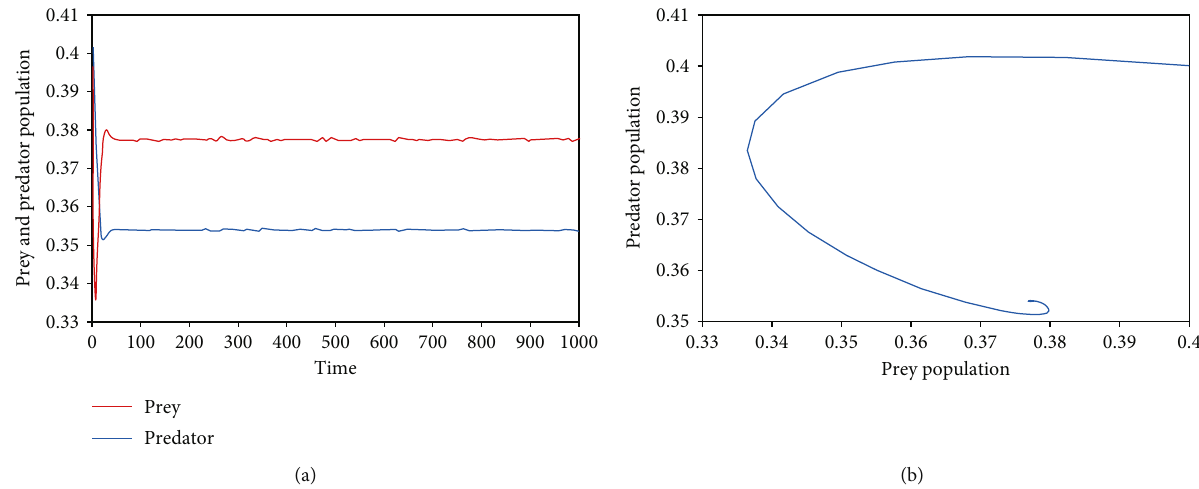
Figure 1: (a) Time series solution of system (4) (b) and parametric plot of the equilibrium point of system (4) approach asymptotically to the coexistence equilibrium point E 2 with parametric values as in Table 2 except c 2 = 0 : 05, c 1 = 0 : 3, and α = 0 : 25, β = 0 : 2